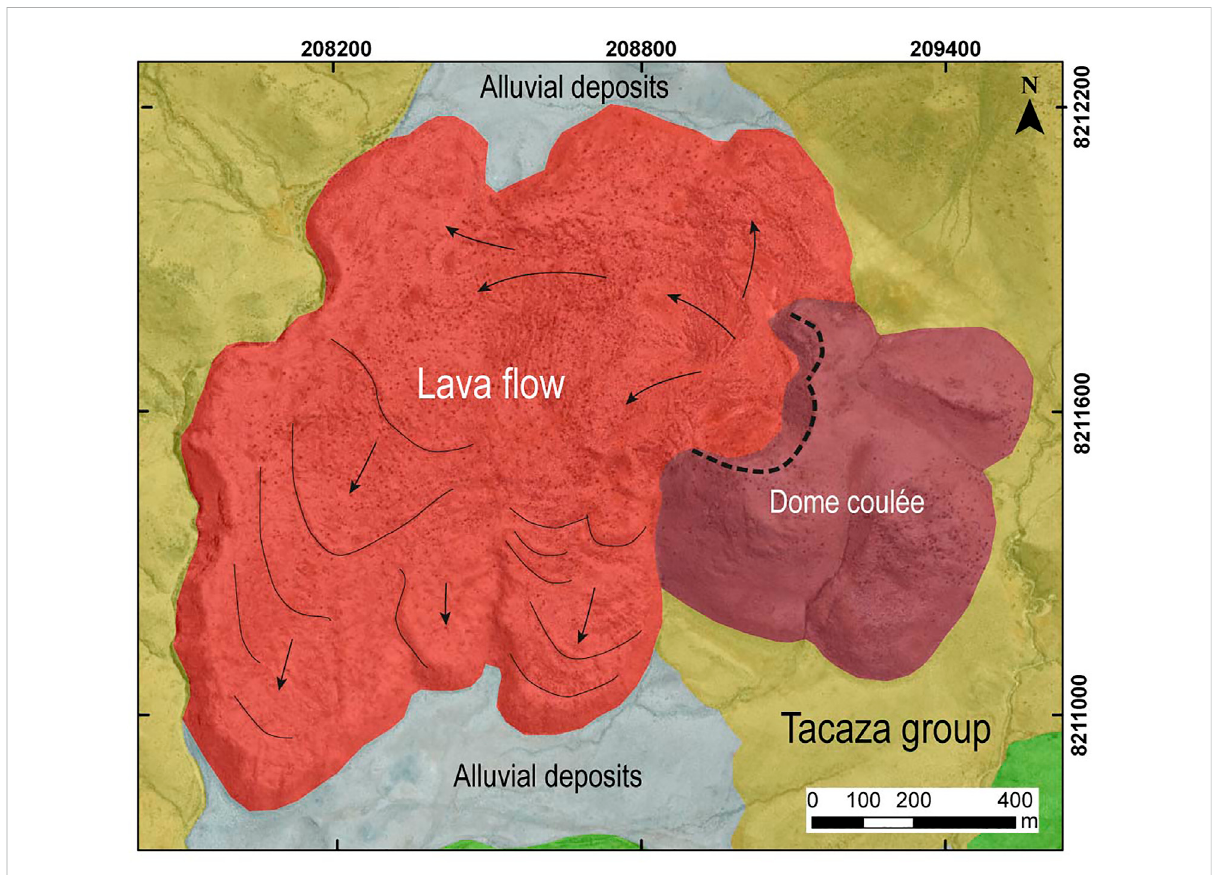
FIGURE 7 Geological map of El Chiral volcanic center, showing two units of dome coulée and lava fl ow